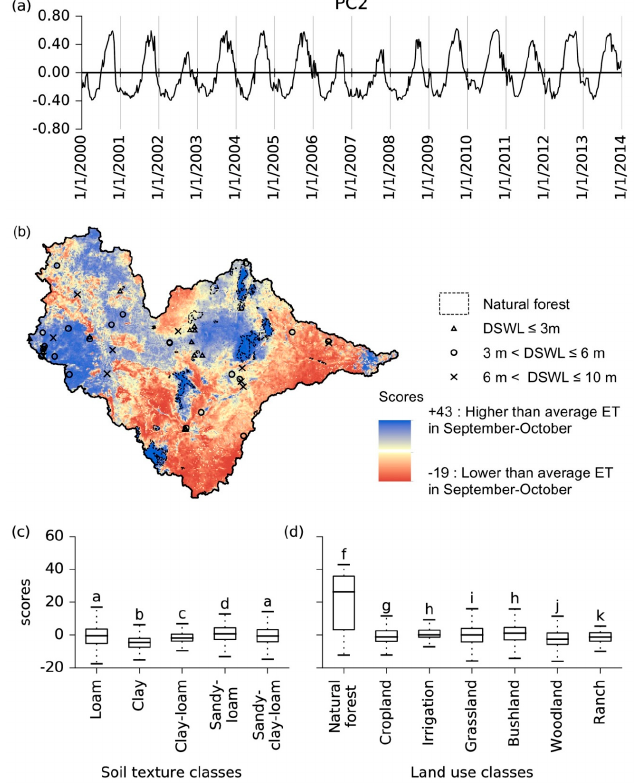
Figure 5. Time series of the loadings on the second principal component (PC2) ( a ). Map of the scores of PC2, natural forest areas and depths to static water levels (DSWL) measured below the ground ( b ). Quartiles of the scores of PC2 for different soil texture ( c ) and land use ( d ) classes, similar score distributions at the 5% level of significance are marked with the same small letter.